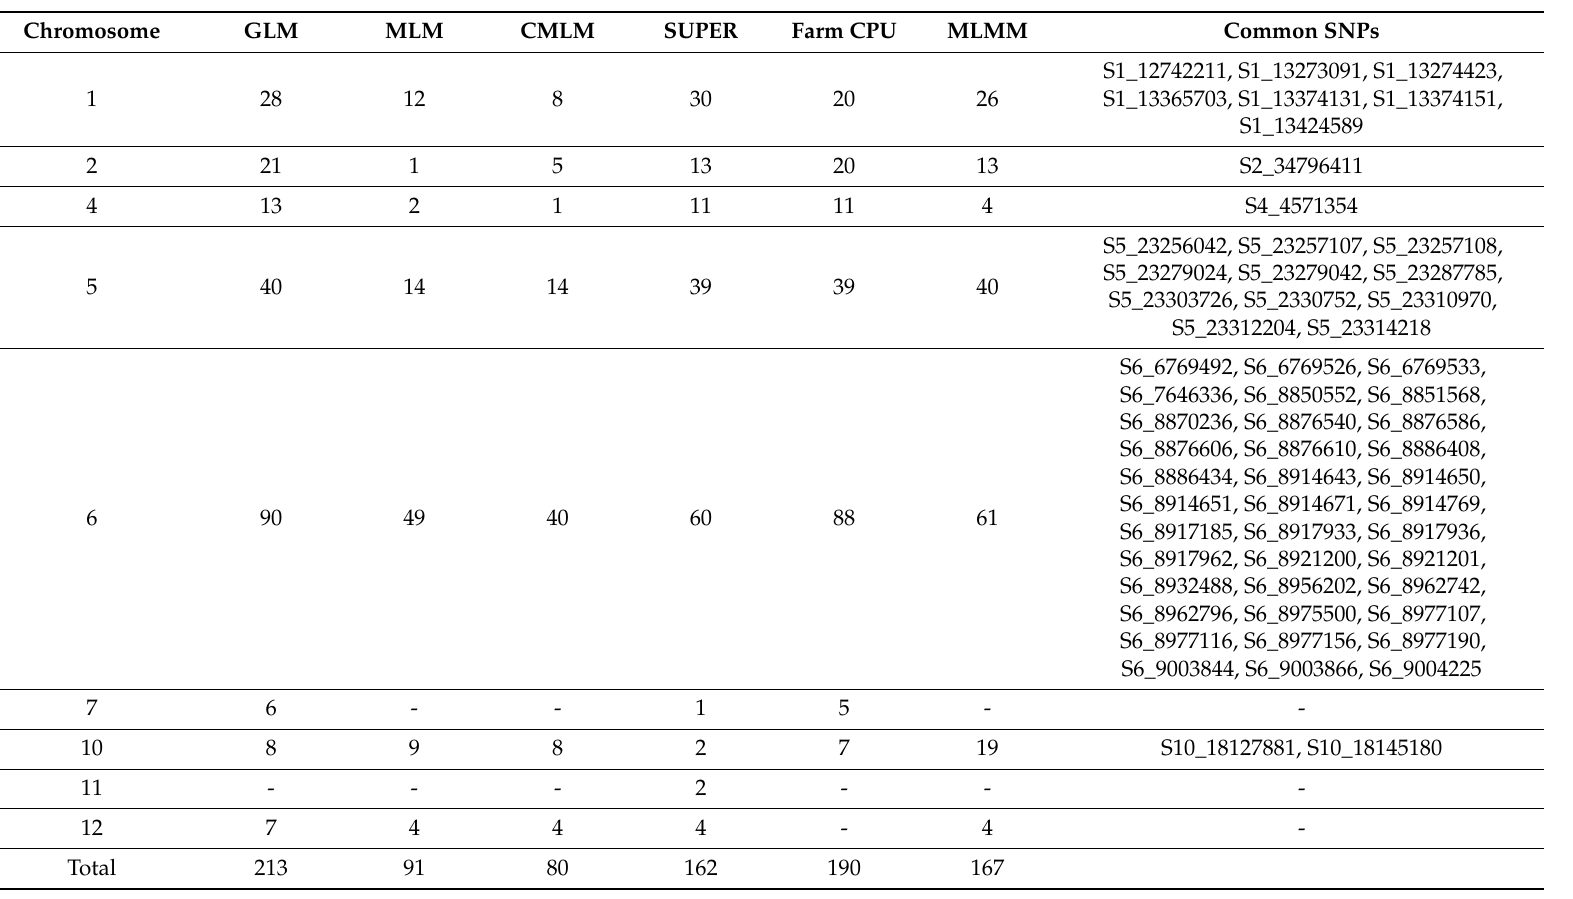
Table 2. Total number and Common Single Nucleotide Polymorphisms mapped across Genome-Wide Association Mapping models. Chromosome GLM MLM CMLM SUPER Farm CPU